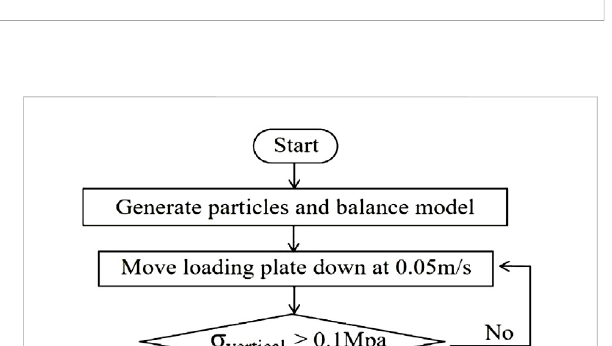
FIGURE 1 Schematic diagram of the particle breakage process based on particle cutting.